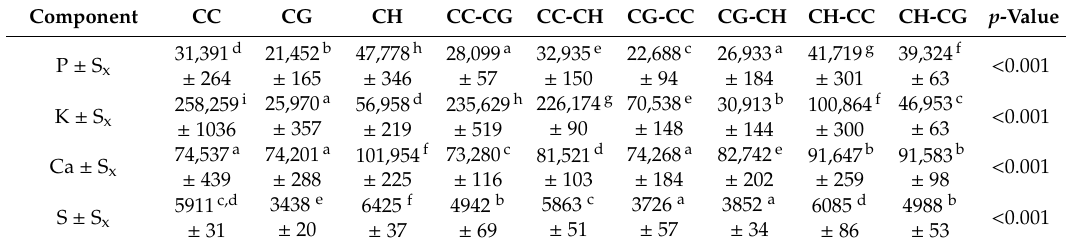
Table 1. Macroelements content in ash from the examined biomass (ppm).